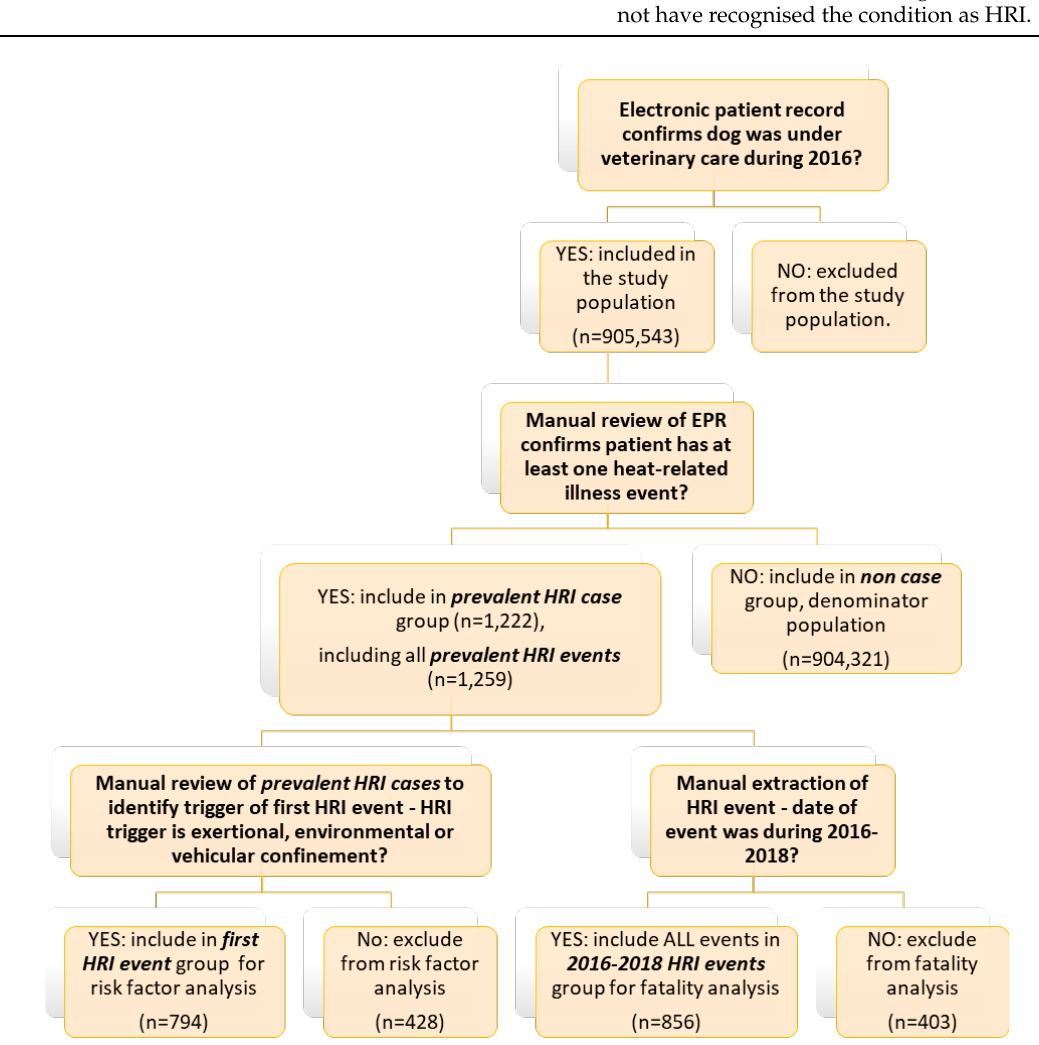
Figure 1. Flow chart of decisions for inclusion in HRI fatality analysis and risk factor analysis for HRI triggers.